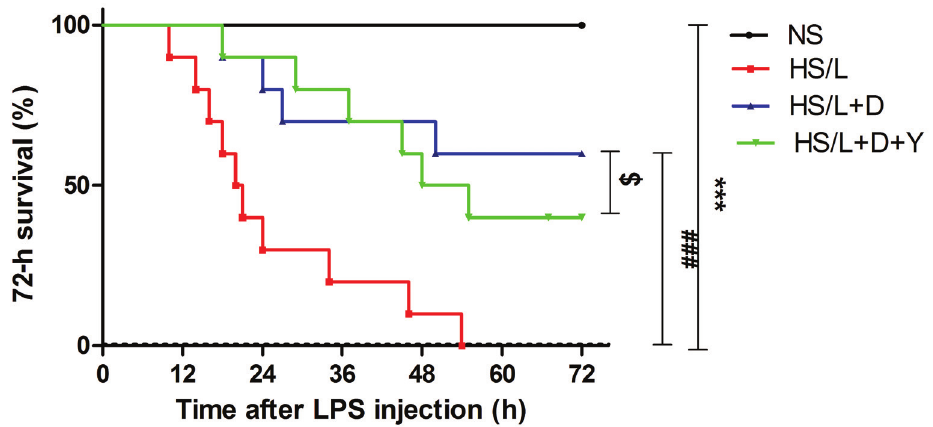
Figure 7. Comparison of 72-h survival of rats treated with normal saline (NS), hemorrhage/resuscitation plus lipopolysaccharide (HS/L), HS/L plus dexmedetomidine (HS/L + D), and HS/L + D plus yohimbine (HS/L + D + Y). ***P o 0.001 vs NS group; ### P o 0.001 vs HS/ L group; $ P o 0.05 vs HS/L + D group (ANOVA).